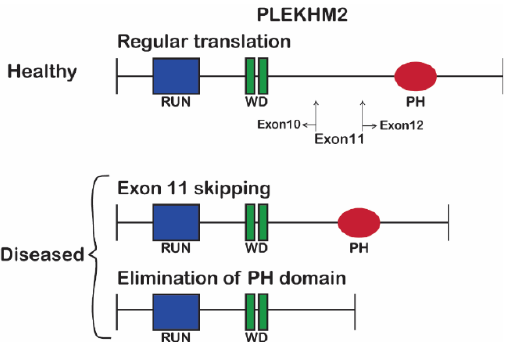
Figure 1. PLEKHM2 protein structure in healthy individuals (top panel) and the two possible variants that are truncated as a result of AG nucleotide deletion in DCM-LVNC patients (bottom panel).